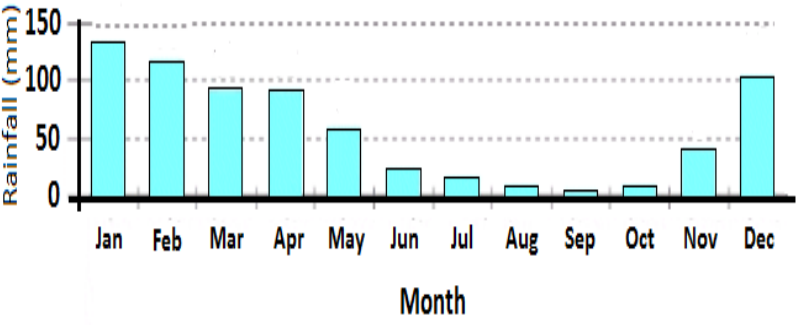
Figure 1. Long-term average rainfall in Vemase, representing the Vemase and Laleia sites. Source: Adapted from Defense Meteorological Support Unit, Australian Bureau of